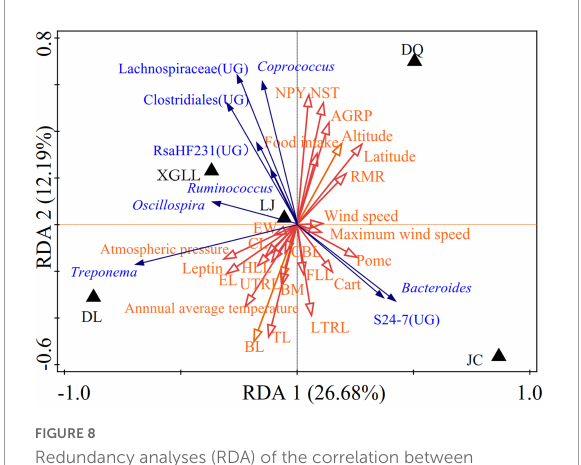
FIGURE8 Redundancy analyses (RDA) of the correlation between environmental physicochemical properties and dominant microbial communities.